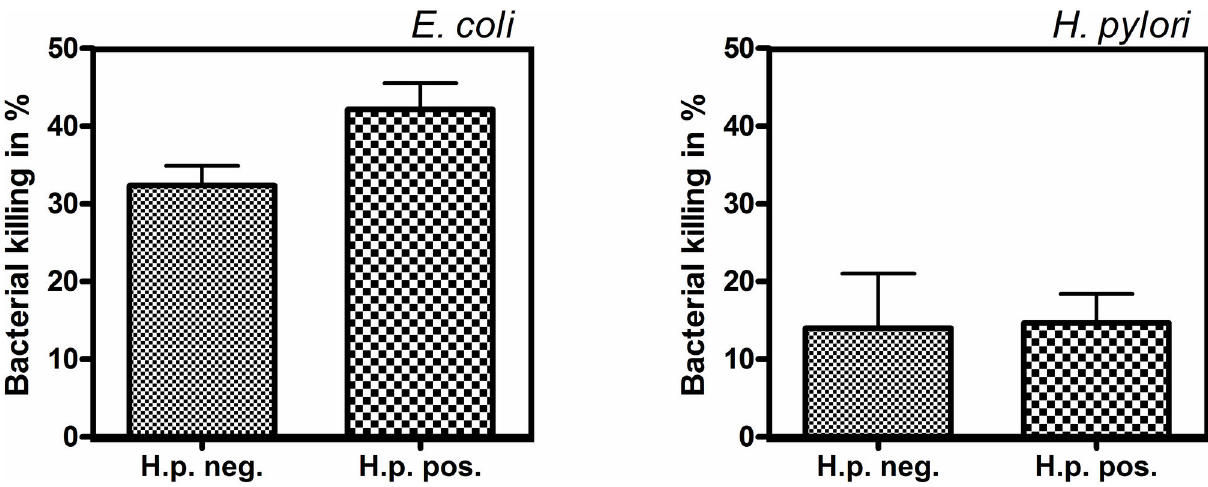
Figure 7. Antimicrobial activity of biopsy extracts. In H. pylori positive biopsy extracts antimicrobial activity towards H. pylori remained consistent compared with Helicobacter negative extracts. Thus Helicobacter did not induce helicobactericidal factors, whereas in Helicobacter positive extracts the antimicrobial effect towards E. coli was increased.